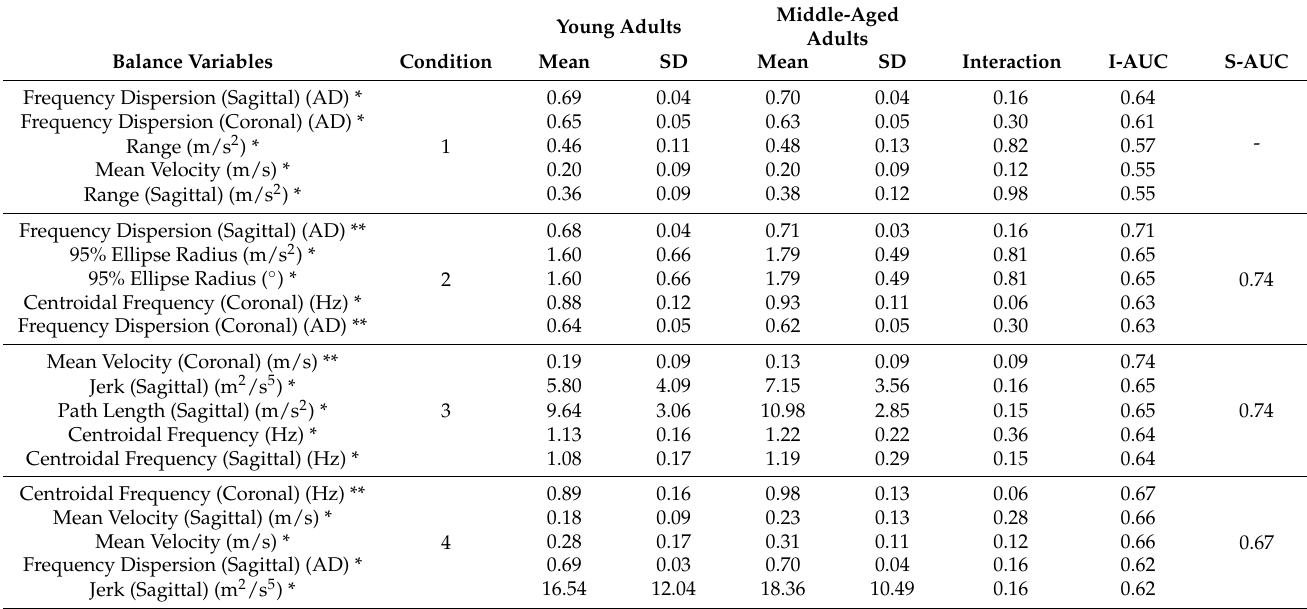
Table 8. Top five AUC variables for each balance condition. The variable(s) with a solitary (*) denote a top five AUC variable for that condition, those with a double (**) were withheld in the stepwise regression model. Condition 1—eyes open, firm surface, Condition 2—eyes closed, firm surface, Condition 3—eyes open, compliant surface, Condition 4—eyes closed, compliant surface, I-AUC—independent AUC value, S-AUC—stepwise AUC